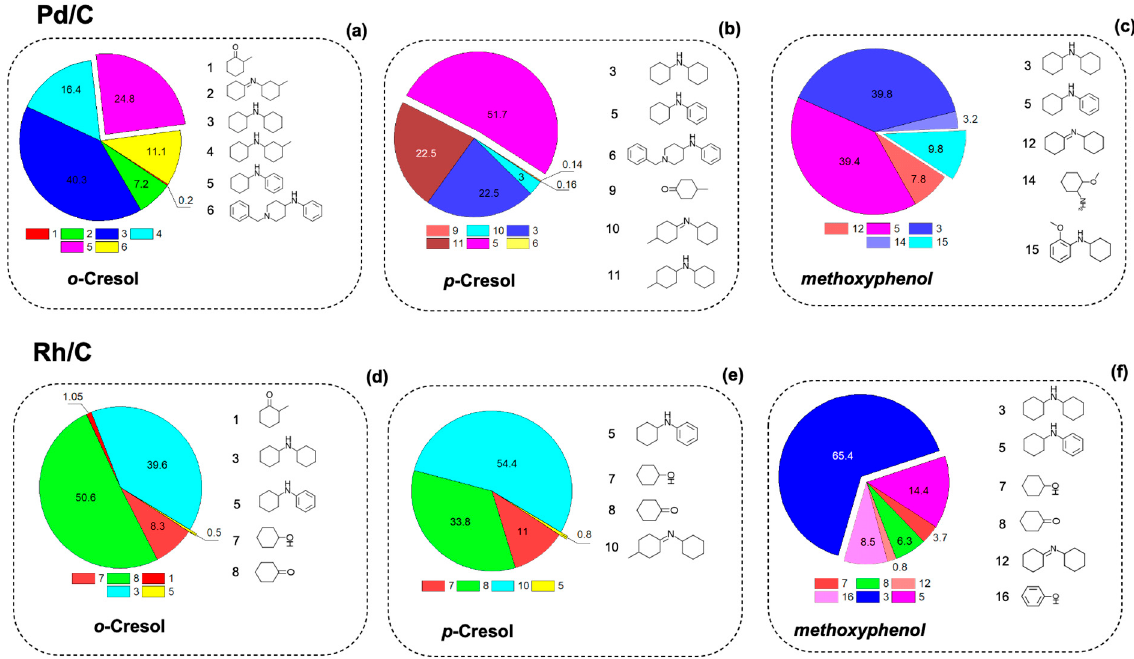
Figure 6. Influence of the type and position of substituents on the product distribution obtained from the phenolics reductive amination reaction. Values in the pies are referred to product concentrations (mol/L). ( a – c ) Pd/C ( d – f ) Rh/C. The reactions were carried out using H 2 gas (1.5 bar), C 0Phenolic = 0.2 mol/L, CyA (1.5 Eq to PhOH) and 120 °C with t R = 6h. Details on product identi fi cation can be found in ESI_1.